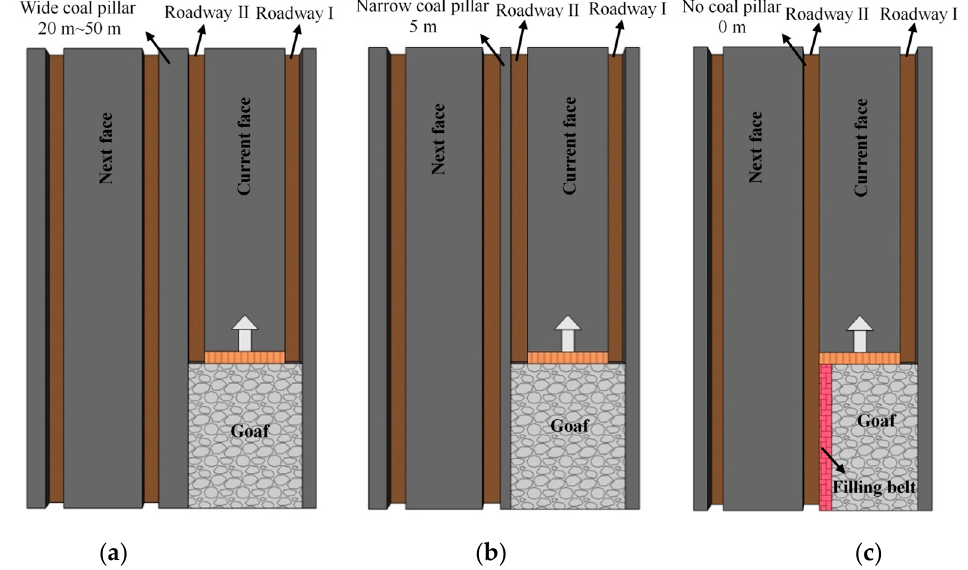
Figure 1. Three typical coal mining modes. ( a ) mining with a wide coal pillar; ( b ) mining with a narrow coal pillar; ( c ) traditional Gob-side Entry Retaining by filling artificial materials.